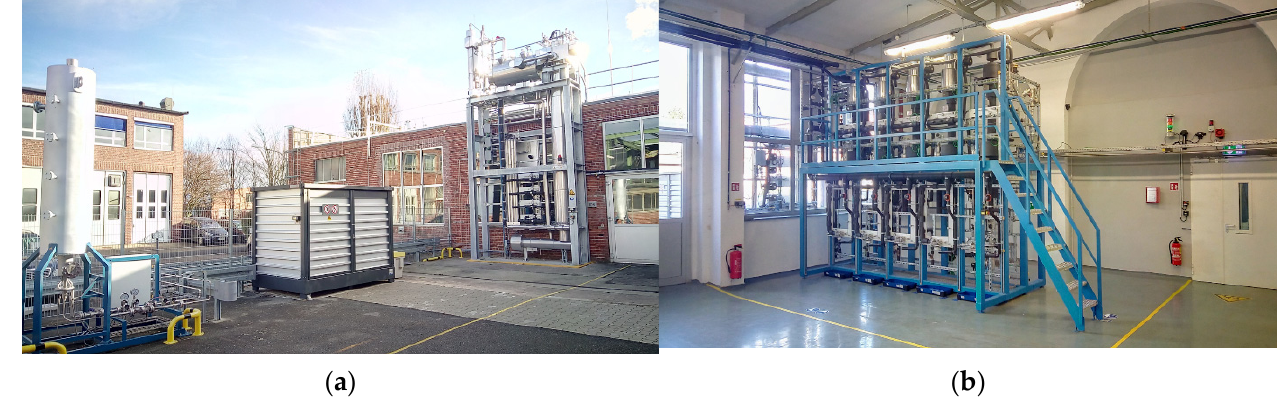
Figure 4. ( a ) Outdoor and ( b ) indoor sections of ALFE_CH3OH_PLP. For the test campaign, four stages were filled with a commercial methanol